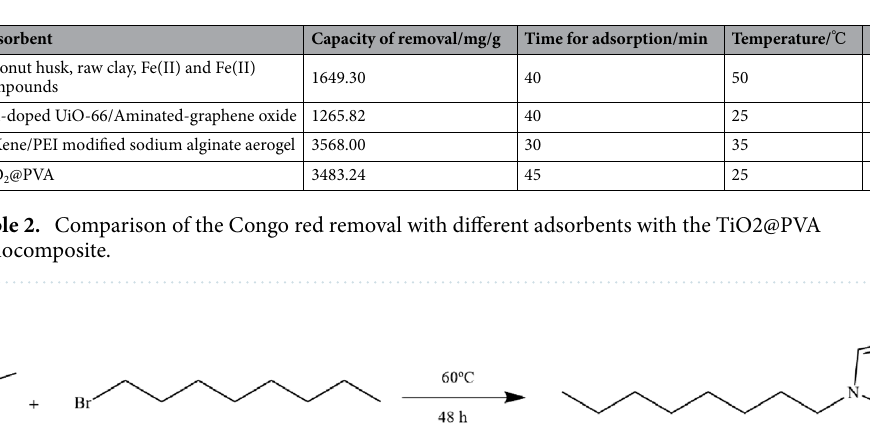
Figure 14. The reaction for preparation of 1-methyl-3-octylimidzaolium